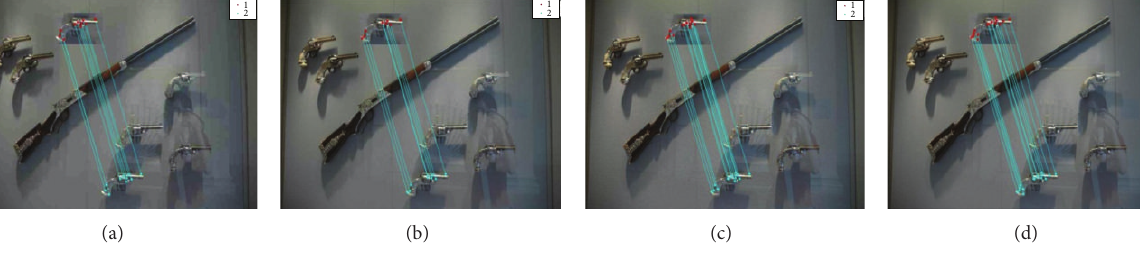
Figure 5: Copy paste detection results for compression: (a) JPEG image quality factor 20, (b) JPEG image quality factor 40, (c) JPEG image quality factor 60, and (d) JPEG image quality factor 80.